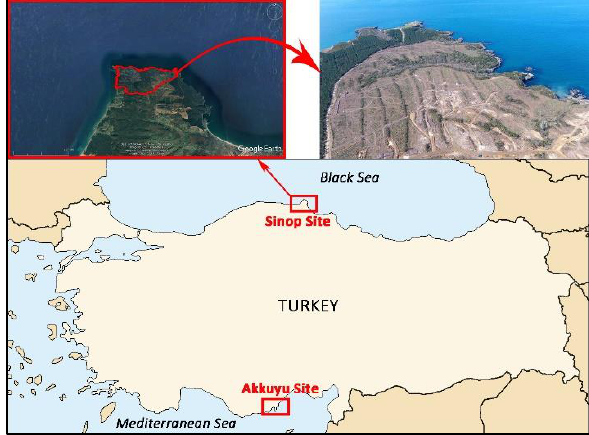
Figure 2. The map and images of the Sinop nuclear power plant.